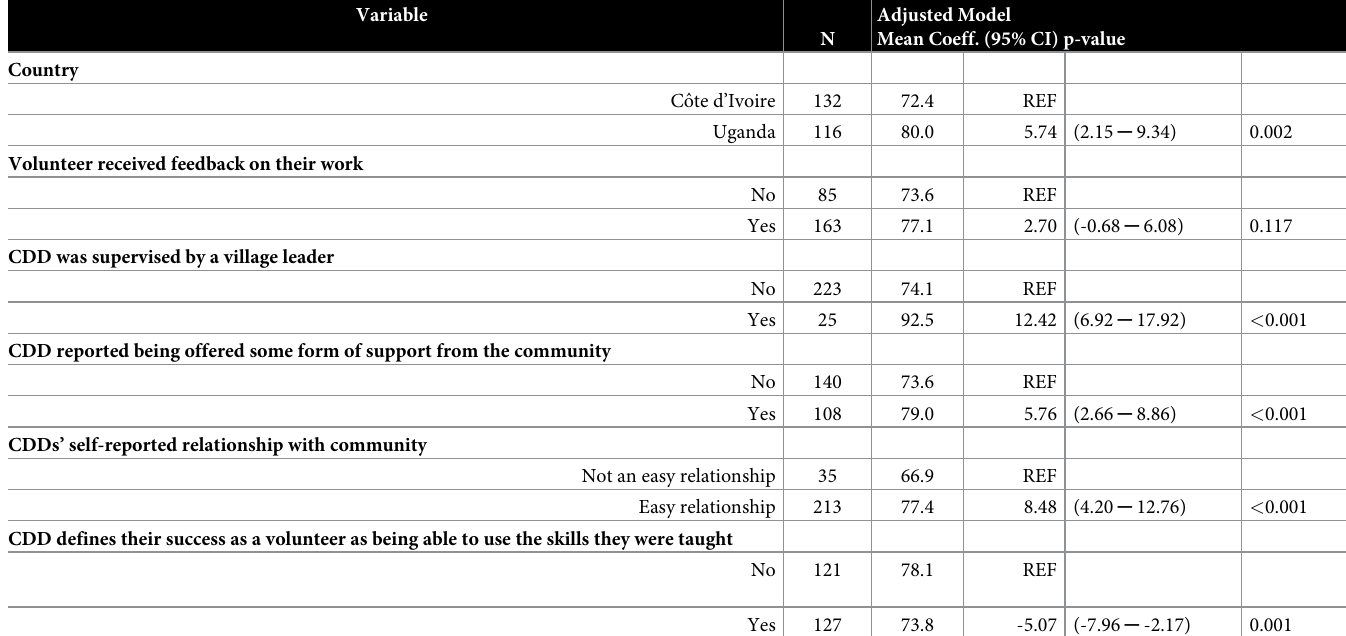
Table 10. Correlates of CDDs’ scores on the CD-RISC-25